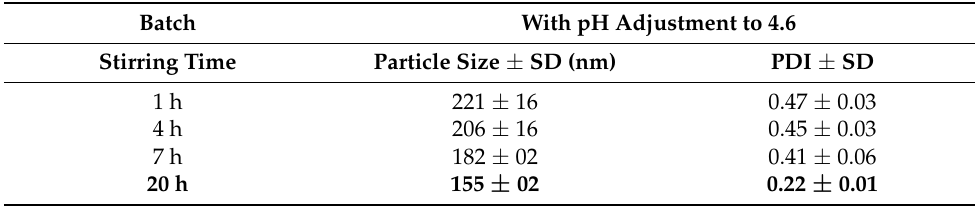
Table 3. Optimization of stirring time of chitosan solution for BC-NPs. Batch With pH Adjustment to 4.6 Stirring Time